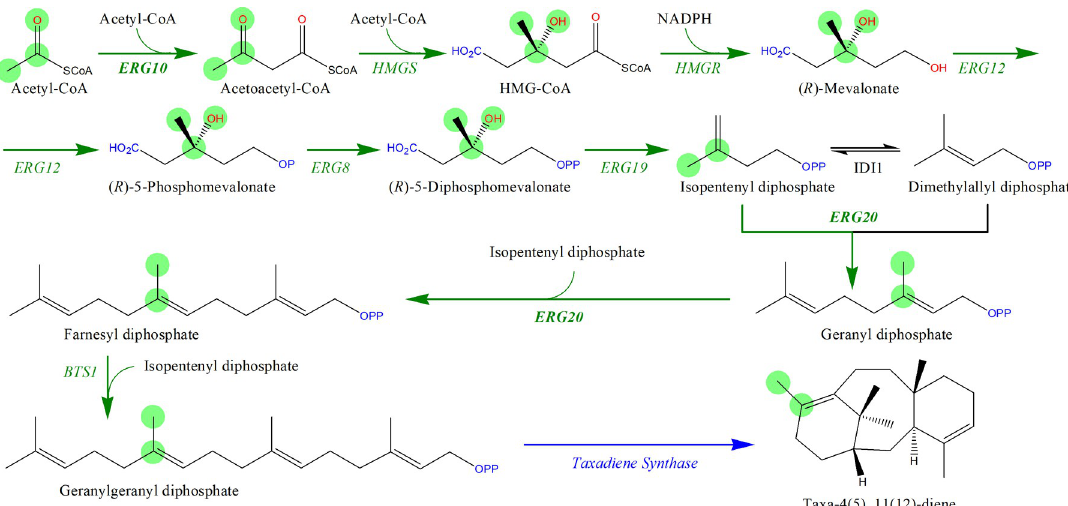
Fig 7. The experimentally validated biosynthesis pathway of taxadiene from acetyl-CoA in S . cerevisiae retrieved by PyMiner. The green arrows indicate endogenous steps while the blue arrows denote exogenous steps. The green circles highlight the atom transfer route from acetyl-CoA to taxadiene. The abbreviations are: ERG10, acetyl-CoA acetyltransferase; HMGS, HMG-CoA synthase; HMGR, HMG-CoA reductase; ERG12, mevalonate kinase; ERG8, phosphomevalonate kinase; ERG19, mevalonate diphosphate decarboxylase; ERG20, farnesyl diphosphate synthase; and BTS1, geranylgeranyl diphosphate